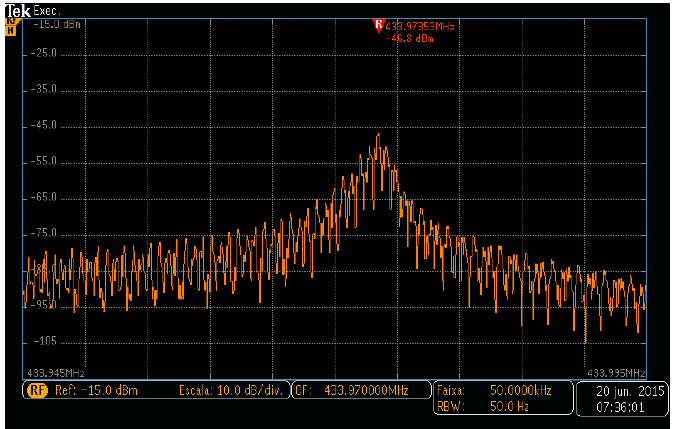
Figura 4: Espectro do sinal ativo com banda de 50 kHz. Fonte: Autores, (2018).